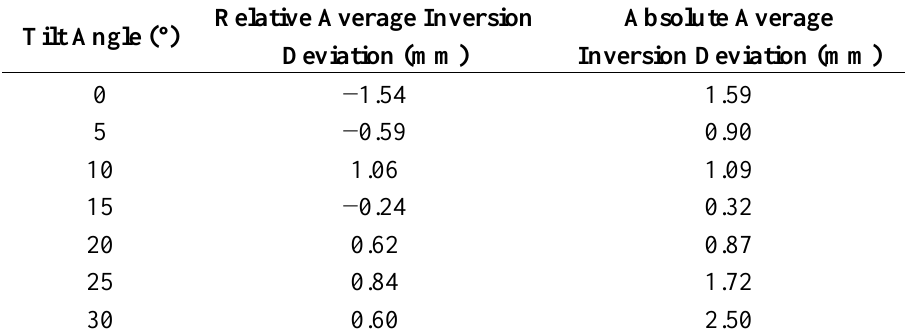
Table 2. Comparison of the inversed and the measured values of horizontal displacement ( Z = 115 0